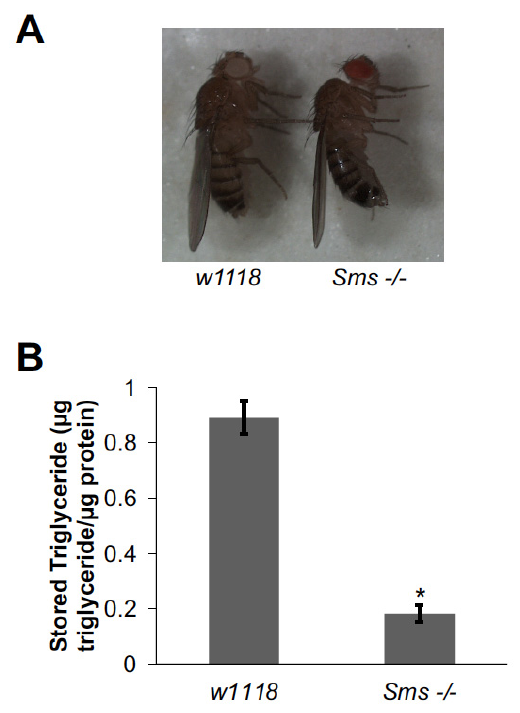
Figure 2. Spermine synthase ( Sms ) mutant flies store less triglyceride than control flies. ( A ) One-week-old female Sms -/- flies displayed a smaller abdomen compared to w1118 controls. A representative image is shown. ( B ) Triglycerides were measured in Sms -/- mutants by homogenizing pairs of one-week-old adult female flies and w1118 controls. Triglyceride measurements were normalized by dividing by total protein content. Bars represent means ± S.E. ( n = 22–25). * p < 0.05 using Student’s t -test comparing Sms -/- to w1118 controls.